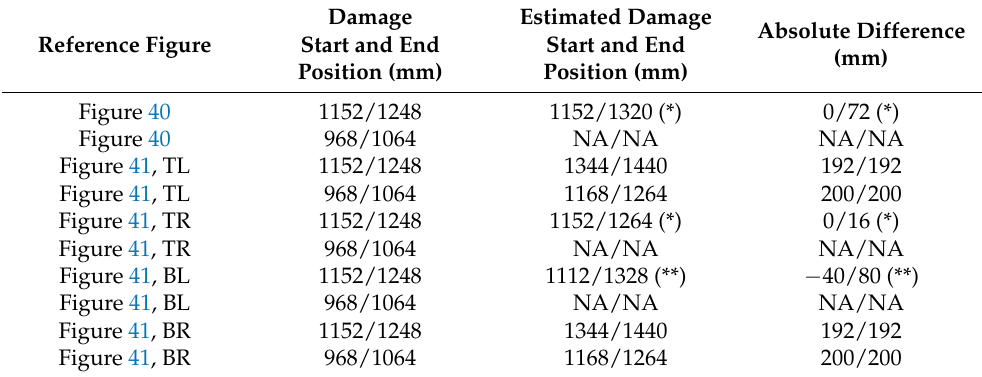
Figure 41. Results by referring separately to time ( a , c ) and space ( b , d ) characteristic parameters for bending 2 ( a , c ), and non-symmetrical excitations 4 ( b , d ); magnifications on the right of each picture. Table 8. Systematic comparison of the reported predictions (Figures 40 and 41): damage start and finish. TL = top left; TR = top right; BL = bottom left; BR = bottom